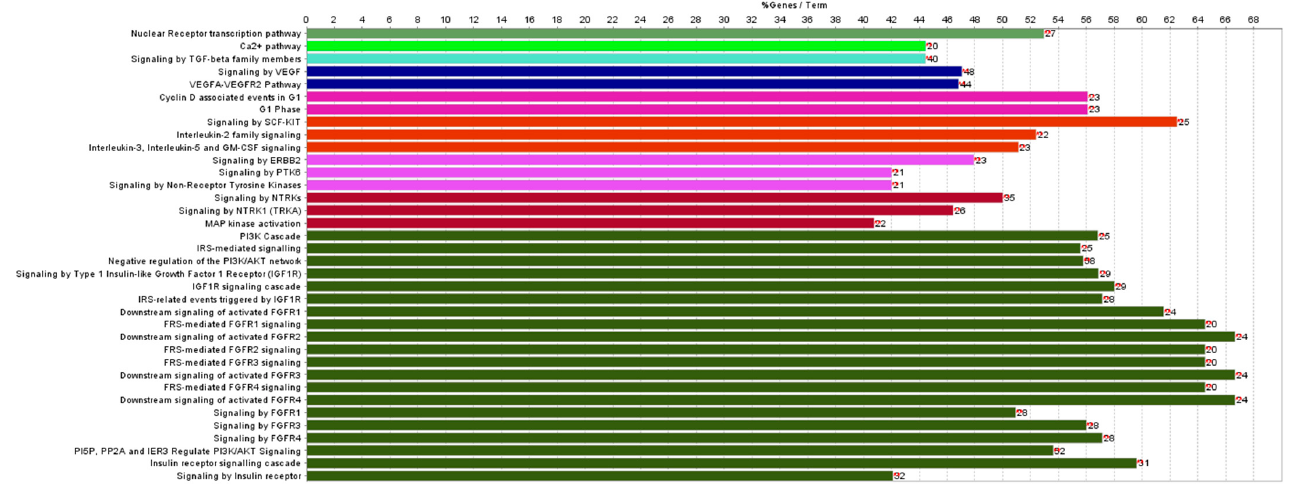
Figure 2. Histogram showing the most significant REACTOME pathways associated with the statistically significant miRNAs (after genes enrichment) altered in WBI vs. SI mouse hearts (listed in Table S2). The single line represents specific gene ontology (GO) terms obtained from the ClueGo analysis. The colors indicates specific clusters of the differentially expressed genes between PBI and WBI samples. * p < 0.05. Red asterisks refer to significance in the percentage of pathway deregulation (* p < 0.05, ** p <